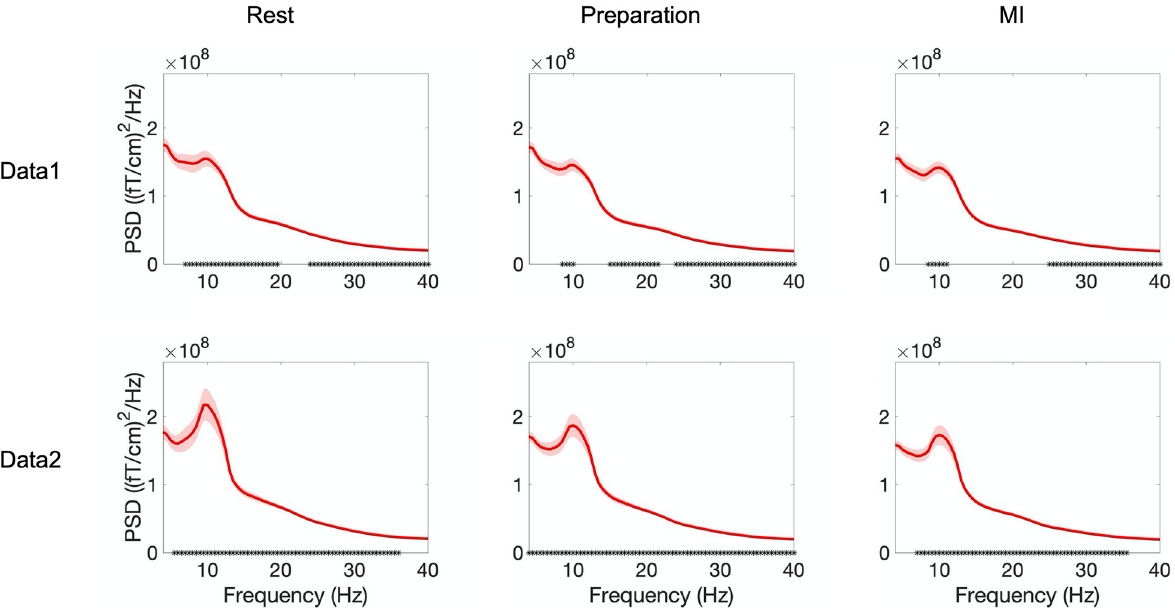
Fig 4. Frequency spectra averaged over all gradiometers. Frequency spectra (average across all gradiometers) when delivering visual (Data 1) and proprioceptive (Data 2) feedback, separately during rest, preparation and MI. Frequencies showing a significant ( p < 0.05) linear power increase over trials are marked on the frequency axis with asterisks. Shaded areas represent the standard error of the mean (SEM) over subjects.